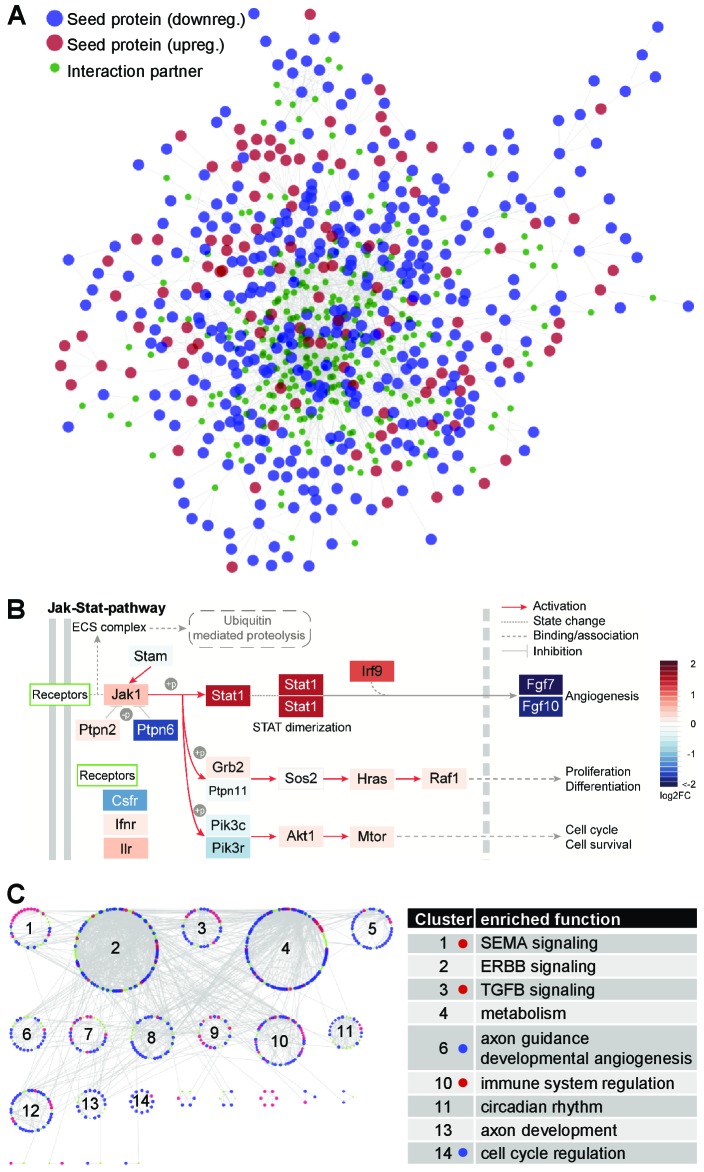
The quiescence-dependent interactome of lung EC.(A) The EC quiescence interactome. EC quiescence-specific network generated from differentially regulated ‘seed’ genes (p<0.05). By means of the DIAMOnD algorithm (Ghiassian et al., 2015), a network was created starting from this set of proteins by integrating related proteins based on their topological relevance. The final network contained 745 proteins and 1661 interactions, including 484 seed gene products (57.3%). Seeds are shown as big circles (red and blue indicating up and down regulation, respectively), while candidate maturation-related proteins are shown as small green circles. (B) Functional enrichment analysis of the EC quiescence interactome led to the identification of JAK-STAT signaling being highly enriched (p=5.7×10-11). Shown by color-code is the quiescence-dependent gene regulation of individual JAK-STAT pathway members (red, upregulated; blue, downregulated). (C) Clustering of the quiescence-dependent interactome identified densely connected gene communities (left). Functional enrichment analysis associated the clusters with biological meaning (right). Color-code as in (A). Dots in table indicate significant overrepresentation of up- (red) or down- (blue) regulated seed proteins.